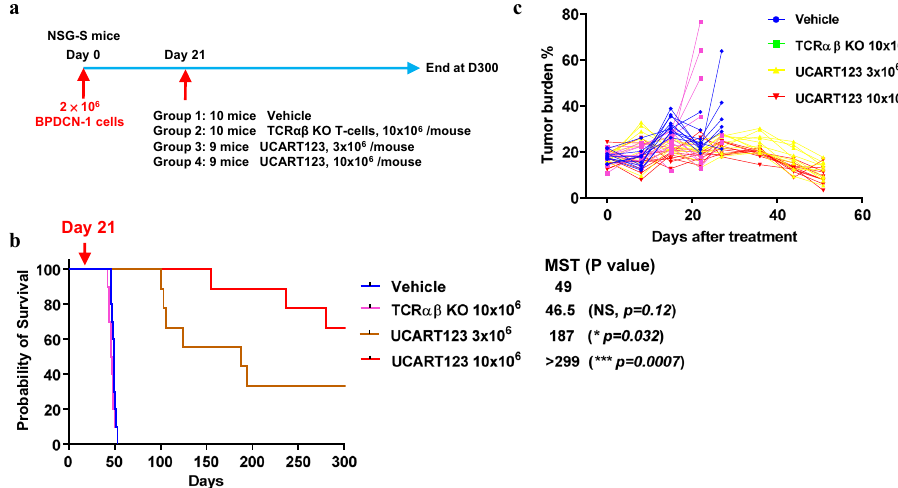
Fig. 3 UCART123 treatment results in long-term survival of primary BPDCN PDX. a Experimental design. NSGS mice were injected intravenously with 2 × 10 6 cells from BPDCN-1 (68.4% CD123 + ) at day 0. Engraftment was con fi rmed by analysis of peripheral blood on Day 21 post tumor cell injection, mice were divided randomly into 4 treatment groups ( n = 9 – 10 mice/group) and received treatment as follows: vehicle; 10 × 10 6 TCR αβ KO T cells; 3 × 10 6 UCART123 cells; or 10 × 10 6 UCART123 cells via single tail vein injection. b Survival of the mice in indicated treatment groups was estimated by the Kaplan- Meier method. Treatment with UCART123 resulted in signi fi cant survival extension. MST = median survival time (in days). Signi fi cance was determined using unpaired two-tailed t-test annotated as “ NS ” (not signi fi cant, p ≥ 0.05), *P ≤ 0.05, ***P ≤ 0.001. c Circulating tumor burden was measured by fl ow cytometry in peripheral mouse blood samples collected on the indicated days (post treatment). Presence of human tumor cells was analyzed using cell surface expression of hCD123 among (DAPI-) viable cells. Source data are provided as a Source data fi BPDCN cell injection, all the mice in the vehicle group were similar to the study with original PDX-3 in cohorts receiving sacri fi ced because of tumor progression. The mice in the high doses of UCART123, tumor progression and death in all UCART123 treatment group died on days 78 – 99; thus, mice of the UCART123 low dose treatment group was now UCART123 treatment extended survival in mice engrafted with associated with emergence of CD123 negative BPDCN clones relapsed BPDCN cells (Supplementary Fig. 12b). However, (Supplementary Fig. 12c).